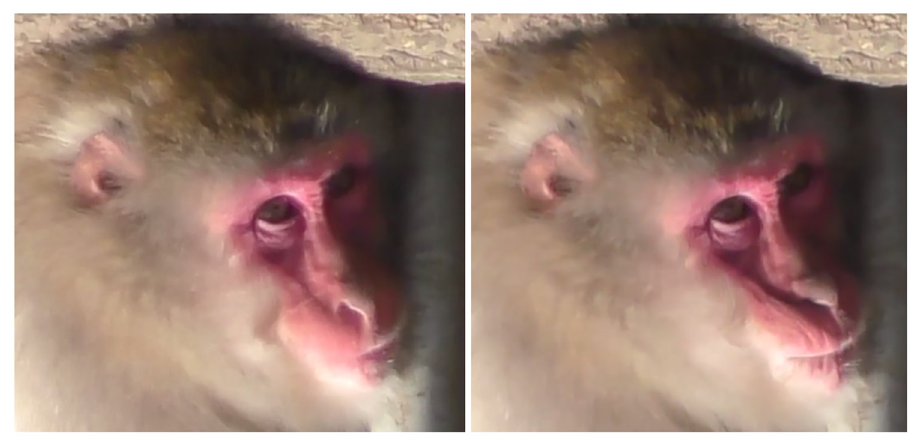
Fig 12. Left: Neutral; Right: AU18i.